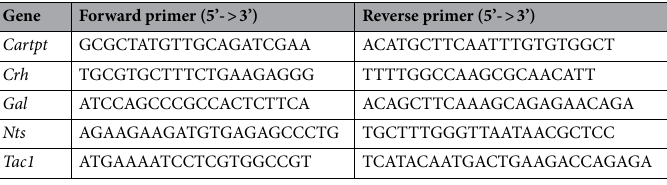
Table 1. Probes used in